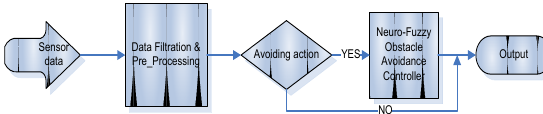
Fig. 5. Framework of control system for proposed smart clothing